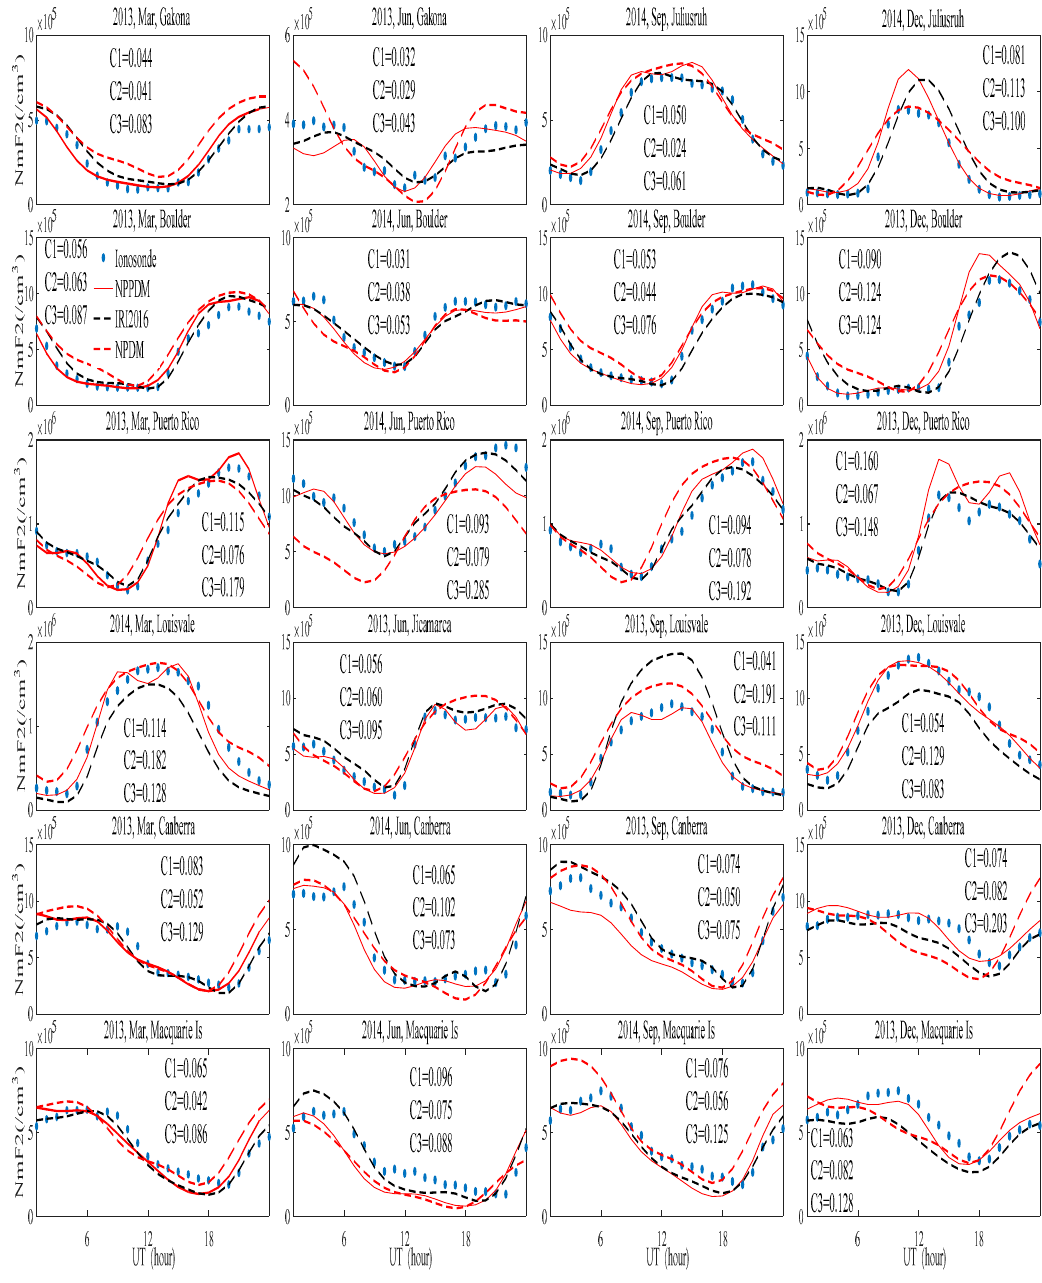
Figure 8. Same as Fig.7, but for high solar activity.